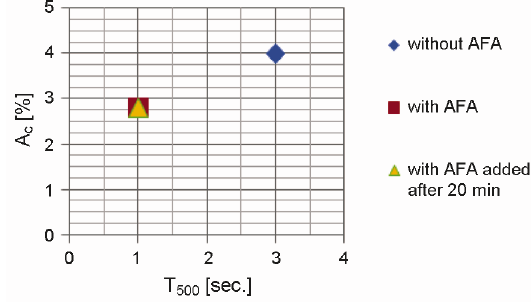
Fig. 12. The relationship between time flow of SCC incorporating different admixtures and air-volume